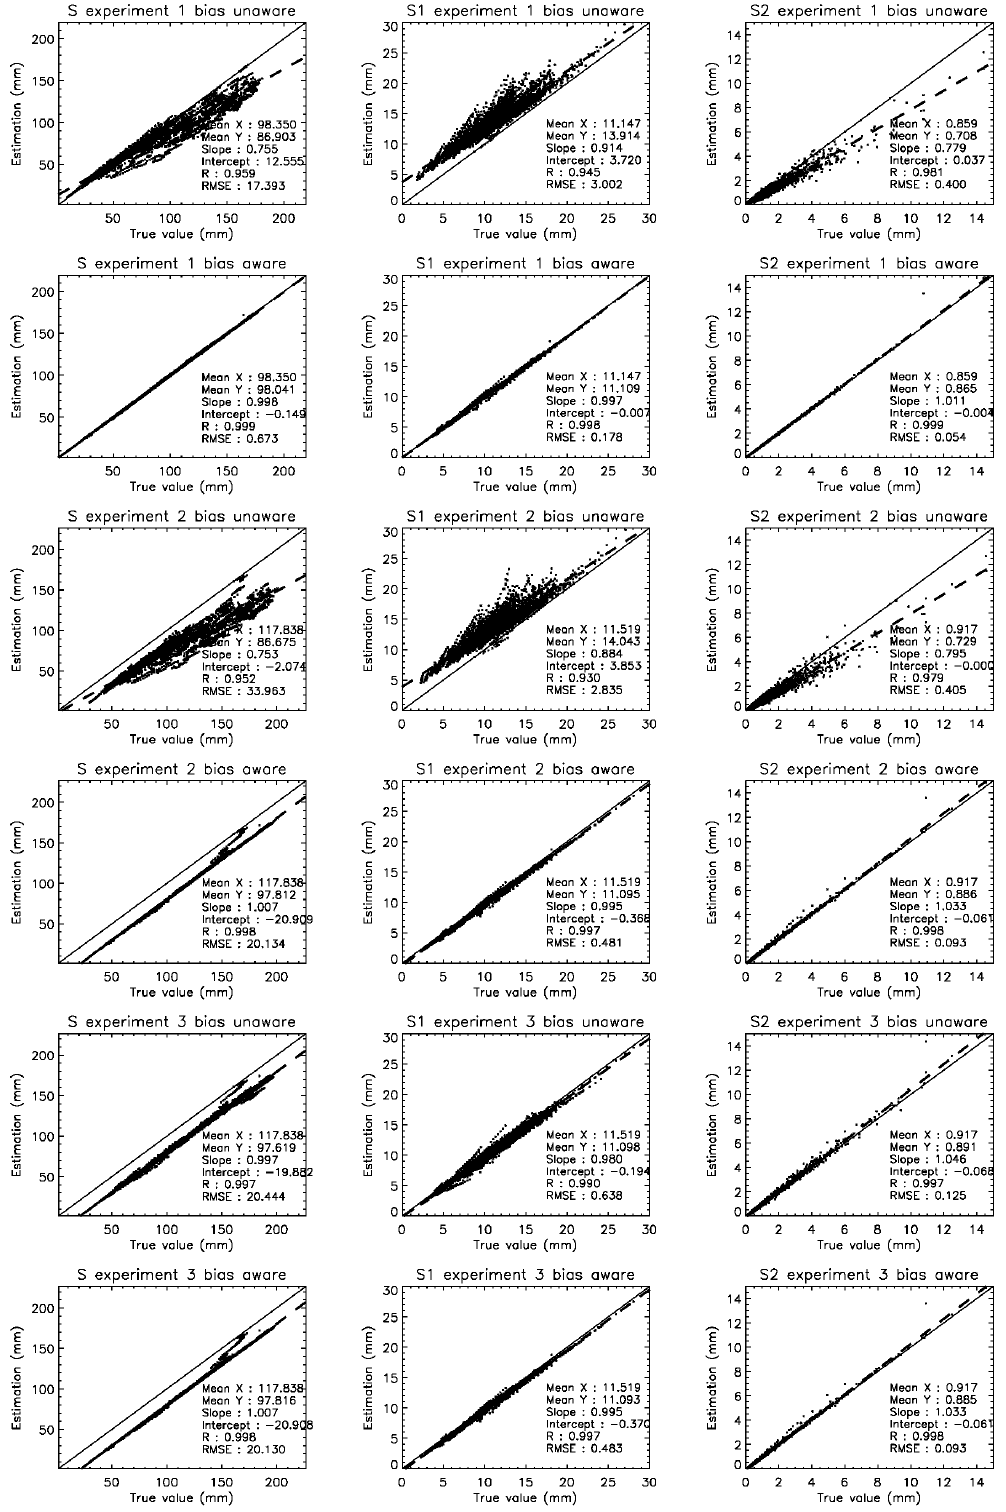
Fig. 6. Comparison of the estimated storages obtained using the bias-aware and a bias-unaware EnKF for the constant observation bias experiment. The dashed lines are the regression lines; the solid lines the 1: line. Synthetic true values are in x axis; estimations in y axis. The top, middle, and bottom two rows show the results of experiments 1, 2, and 3, respectively. The first, second, and third column show the results for S , S 1 , and S 2 ,